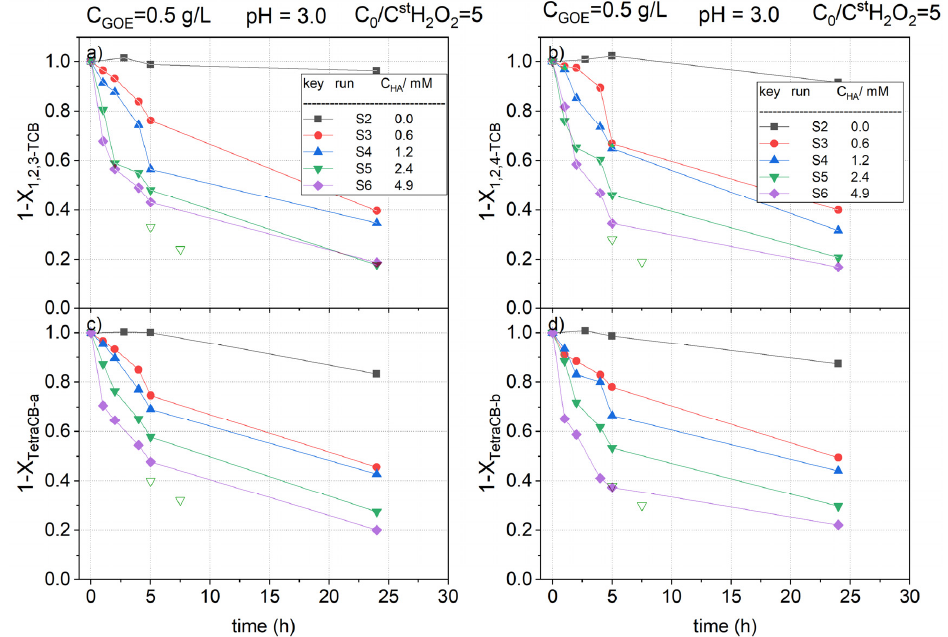
Figure 7. Remaining fractional concentration of ( a ) 1,2,3-trichlorobenzene (1 − 𝑋 (cid:2869),(cid:2870),(cid:2871)(cid:2879)(cid:3021)(cid:3004)(cid:3003) ); ( b ) 1,2,4- trichlorobenzene (1 − 𝑋 (cid:2869),(cid:2870),(cid:2872)(cid:2879)(cid:3021)(cid:3004)(cid:3003) ); ( c ) tetrachlorobenzene-a (1 − 𝑋 (cid:3021)(cid:3032)(cid:3047)(cid:3045)(cid:3028)(cid:3004)(cid:3003)(cid:2879)(cid:3028) ); ( d ) tetrachlorobenzene- b (1 − 𝑋 (cid:3021)(cid:3032)(cid:3047)(cid:3045)(cid:3028)(cid:3004)(cid:3003)(cid:2879)(cid:3029) ) vs. reaction time at pH 0 = 3, 𝐶 (cid:3008)(cid:3016)(cid:3006) = 0.5 𝑔 𝐿 (cid:2879)(cid:2869) , and (𝐶 (cid:3009) 5 (12.43 𝑚𝑀) , at room temperature (controlled at 22 °C). Conversions obtained after addition